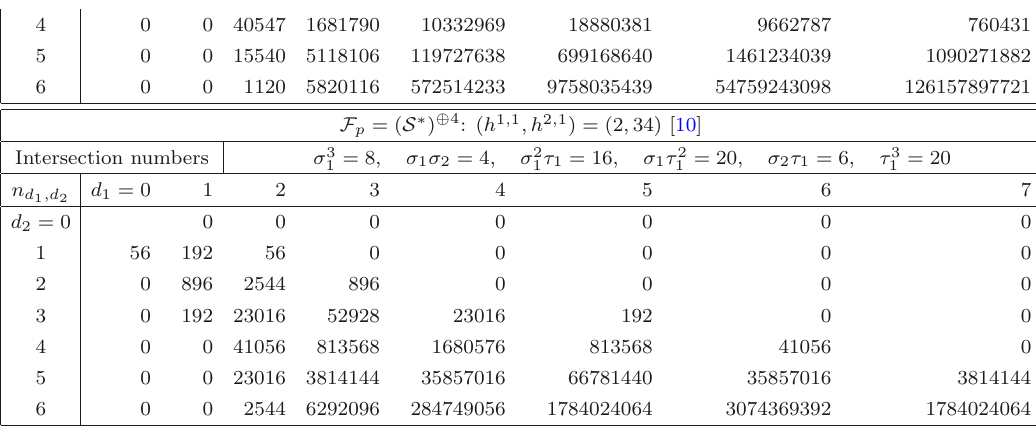
Table 6 . Genus-0 invariants of determinantal 3-folds in (2.25) with V = G (2 ,